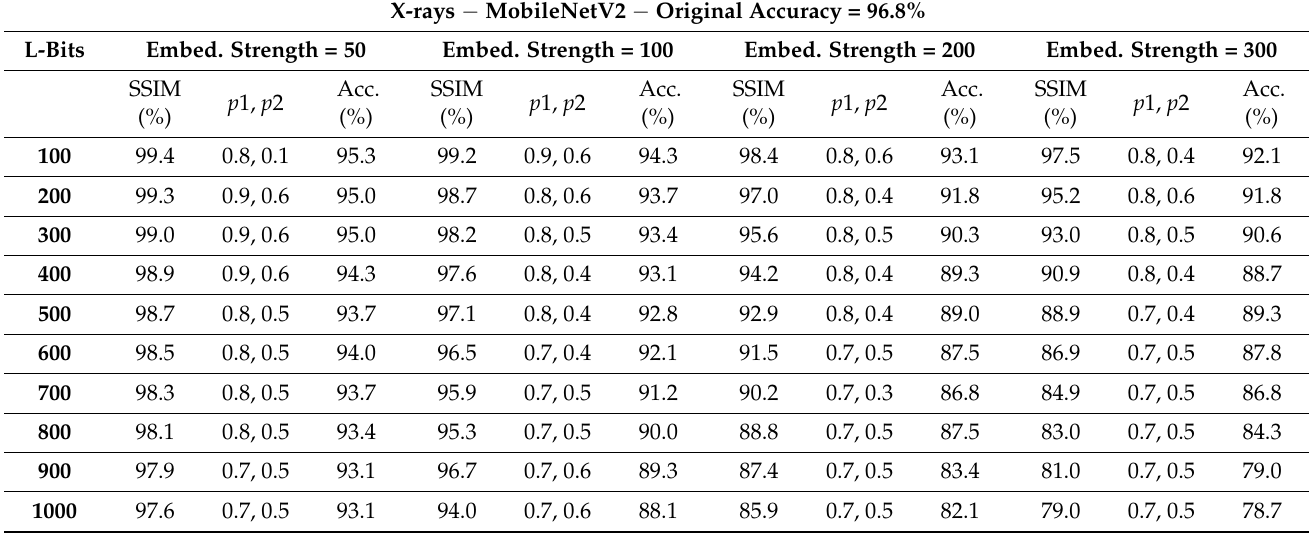
Table 1. KMsWA 2 attack on MobileNetV2 in X-rays dataset.